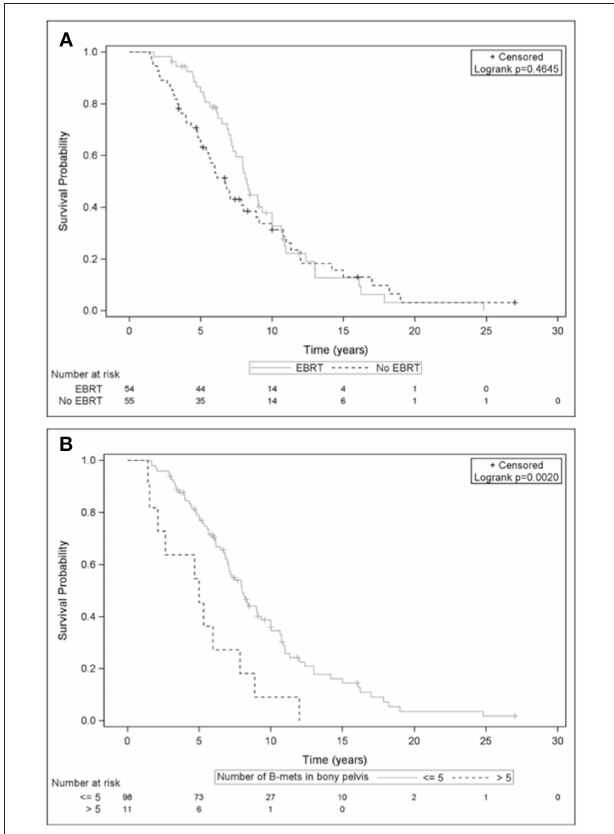
FIGURE 2 | Overall survival curves from initial diagnosis, among patients with localized prostate cancer according to: (A) Whether they received External Beam Radiation Therapy (EBRT group) or not (No-EBRT group). (B) Presence of ≤ 5 bone metastases compared to > 5 bone metastases in the bony pelvis at first bone